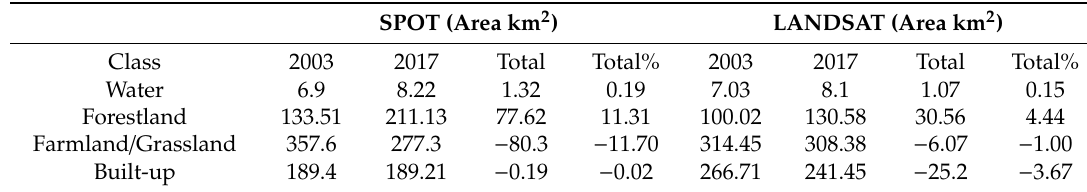
Table 5. Total change in LULC obtained from classified